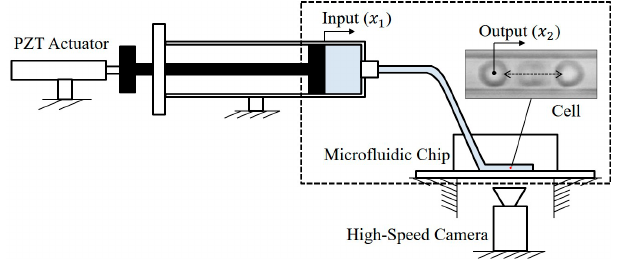
Figure 1. An illustrative diagram demonstrates how cell manipulation is controlled by a macro actuator outside the microfluidic chip.